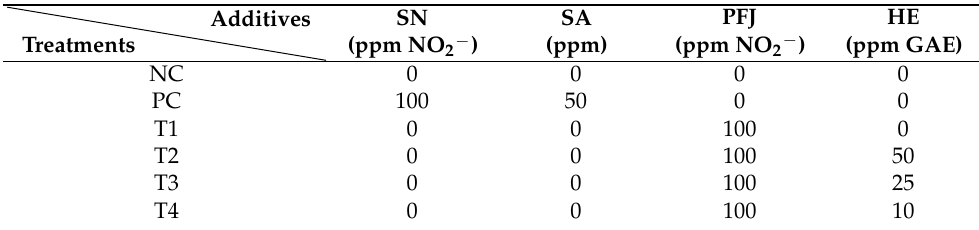
Table 1. Pork mince treatments with sodium nitrite (SN), sodium ascorbate (SA), parsnip fermented juice (PFJ), and hawthorn extract